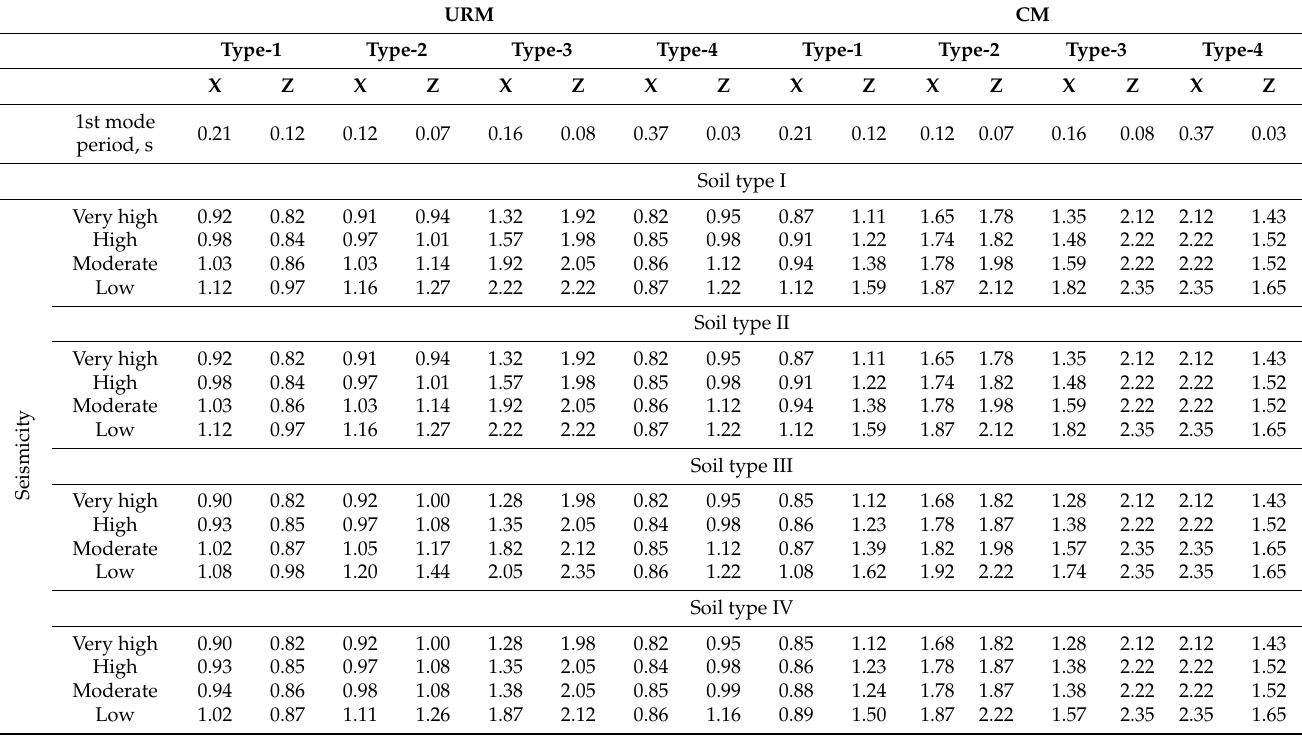
Table 4. RVS basic score of the studied buildings for various seismicity levels and site classes. URM CM